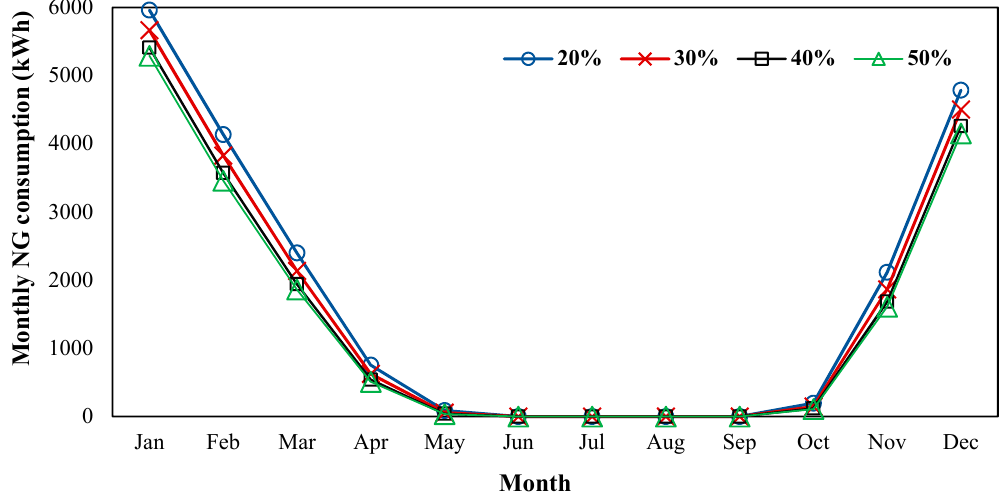
Figure 9. Monthly natural gas consumption for different window-to-wall ratio (WWRs).